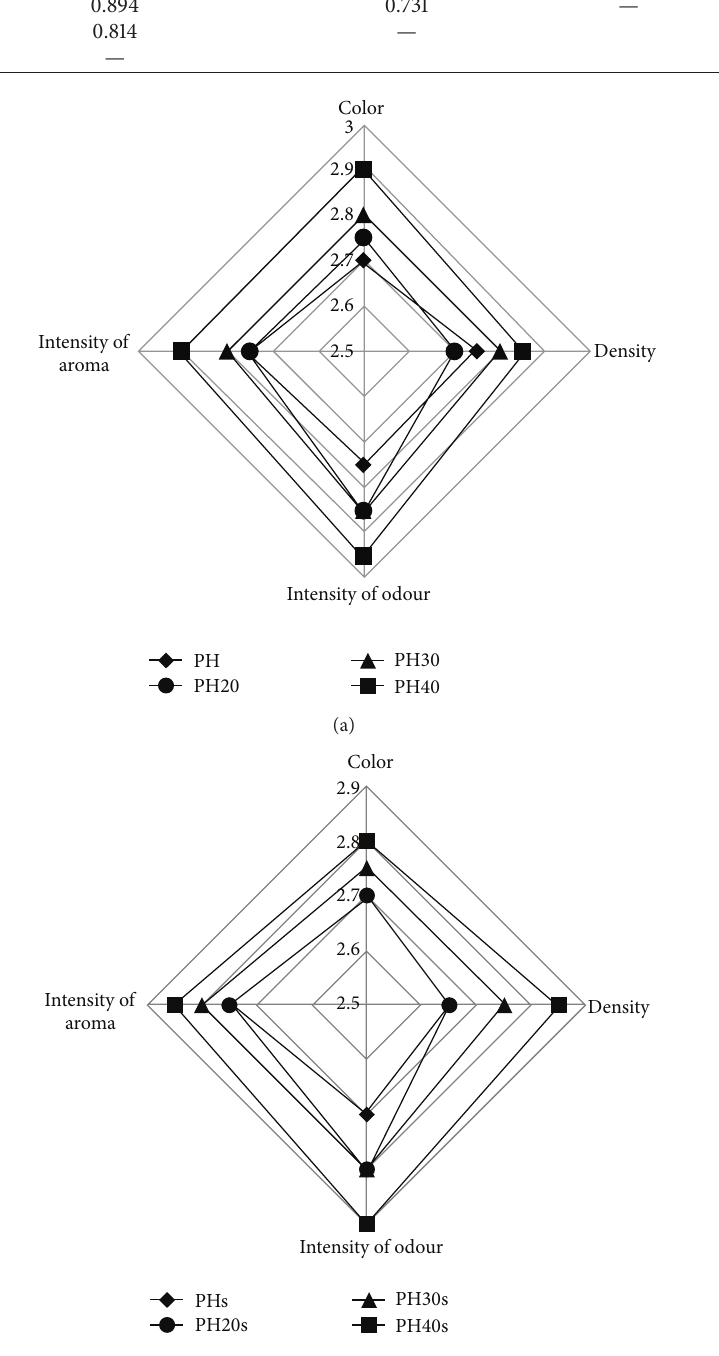
Figure 2: Sensorial characteristics of honey samples. (a) PH samples with addition of dried apricots; (b) PH samples with addition of dried apricots after one-year storage. Scores are means of seven evaluations by five panelists. Scores: 0—unacceptable, 1—acceptable, 2—good, and 3—optimal quality